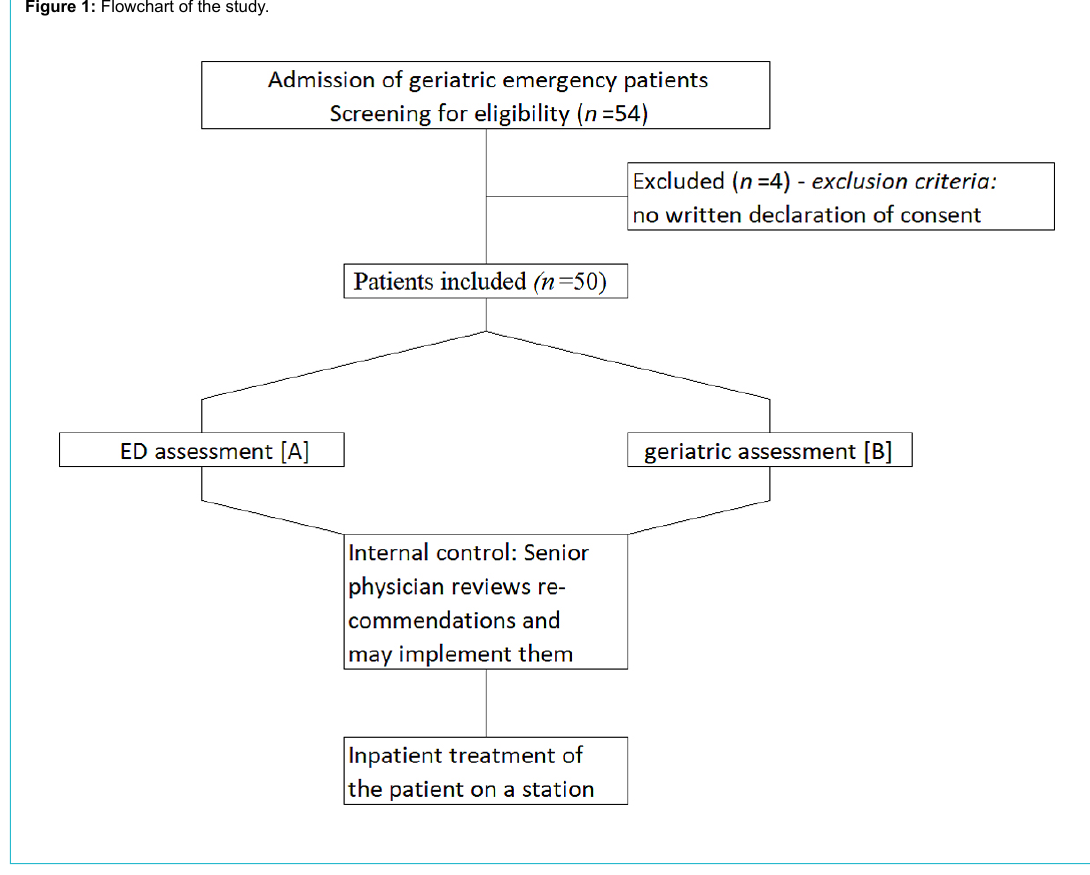
Figure 1: Flowchart of the study.